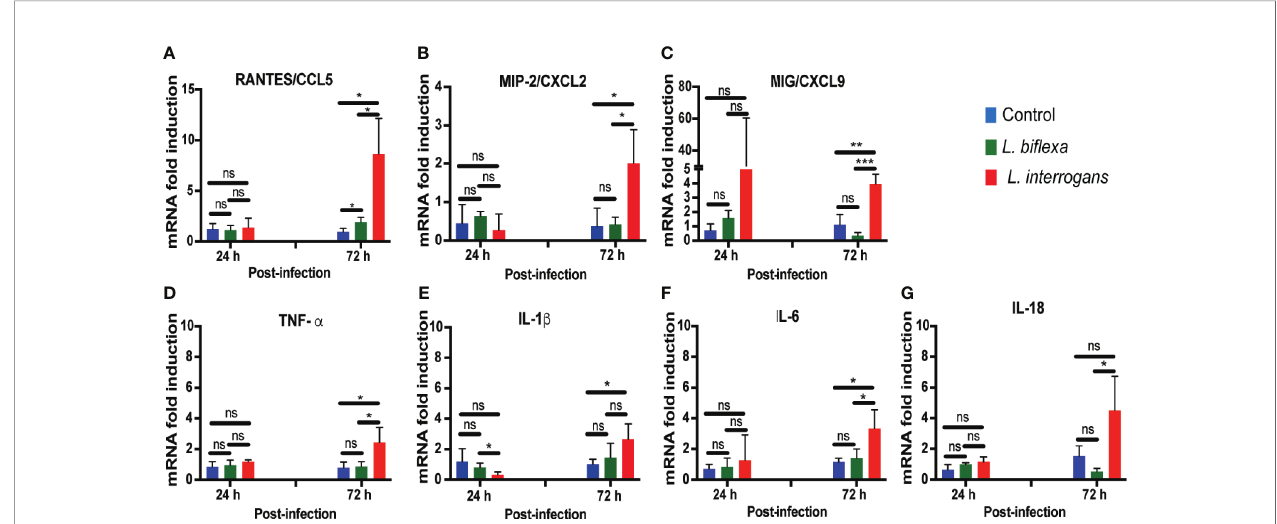
FIGURE 4 | Genetic expression levels of chemo-cytokines in whole blood at 24h and 72h post infection with L. bi fl exa and L. interrogans . Infection was performed with pathogenic and non-pathogenic Leptospira in C3H-HeJ mice via intraperitoneal route with 10 8 bacteria for 24h and 72h. PBS was administered in control mice. We measured genetic expression of in fl ammatory signatures by RT-PCR (Panels A – G ) from whole blood. Statistical signi fi cance was determined by unpaired t-test with Welch ’ s correction between control and infected groups, where *p<0.05, **p<0.01, ***p<0.001, ns, non-signi fi cance; n= 3-4 mice per group. Data represents one of two independent